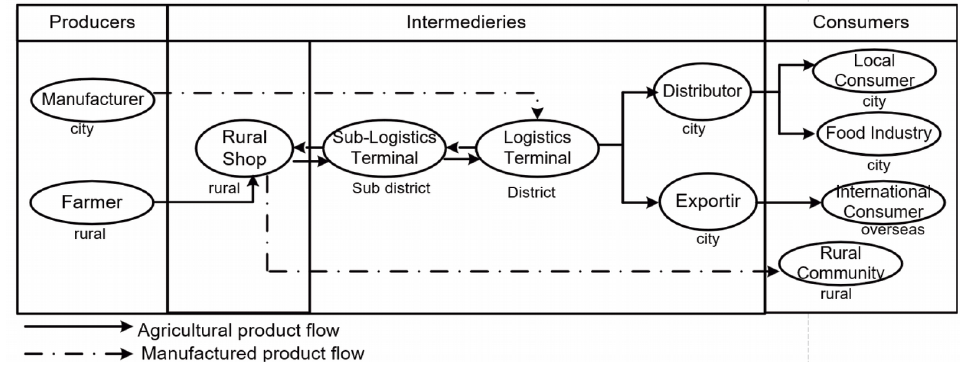
Figure 3. The freight logistics network for rural logistics system model